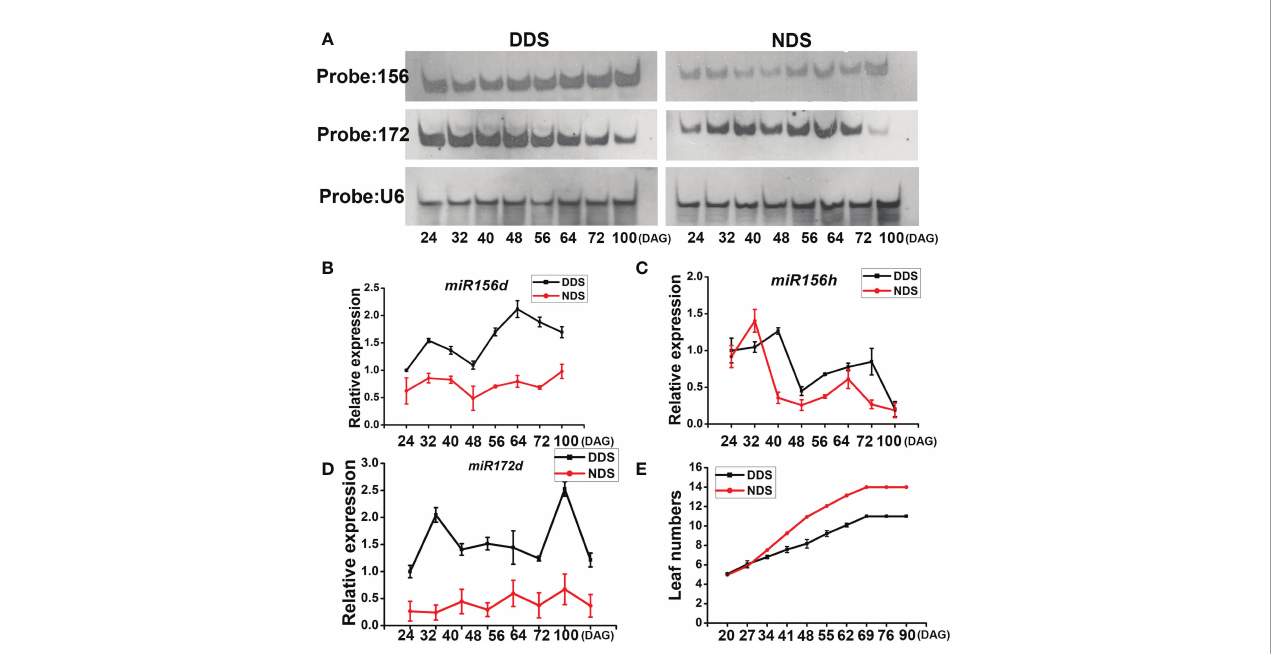
FIGURE 4 Ectopic expression of miR156s and miR172s in DDS plants. (A) Northern blot of miR156s and miR172s expression levels in whole plants at either the adult or juvenile stages between DDS and NDS. The RNA samples in each lane were extracted from whole plants. U6 was used as a loading control. (B, C) A Quantitative reverse transcription polymerase chain reaction (qRT-PCR) analysis of pri-miR156d/h expression between DDS and NDS at 24 、 32 、 40 、 56 、 64 、 72 、 100 DAG. (D) A qRT-PCR analysis of temporal expression of pri-miR172d between DDS and NDS at 24 、 32 、 40 、 56 、 64 、 72 、 100 DAG. (E) A shorter plastochron and fewer leaves were observed for DDS compared to NDS. Error bars represent mean ± SD (n = 3) where the different letters indicate statistical differences by Duncan ’ s multiple range test (p<0.05).